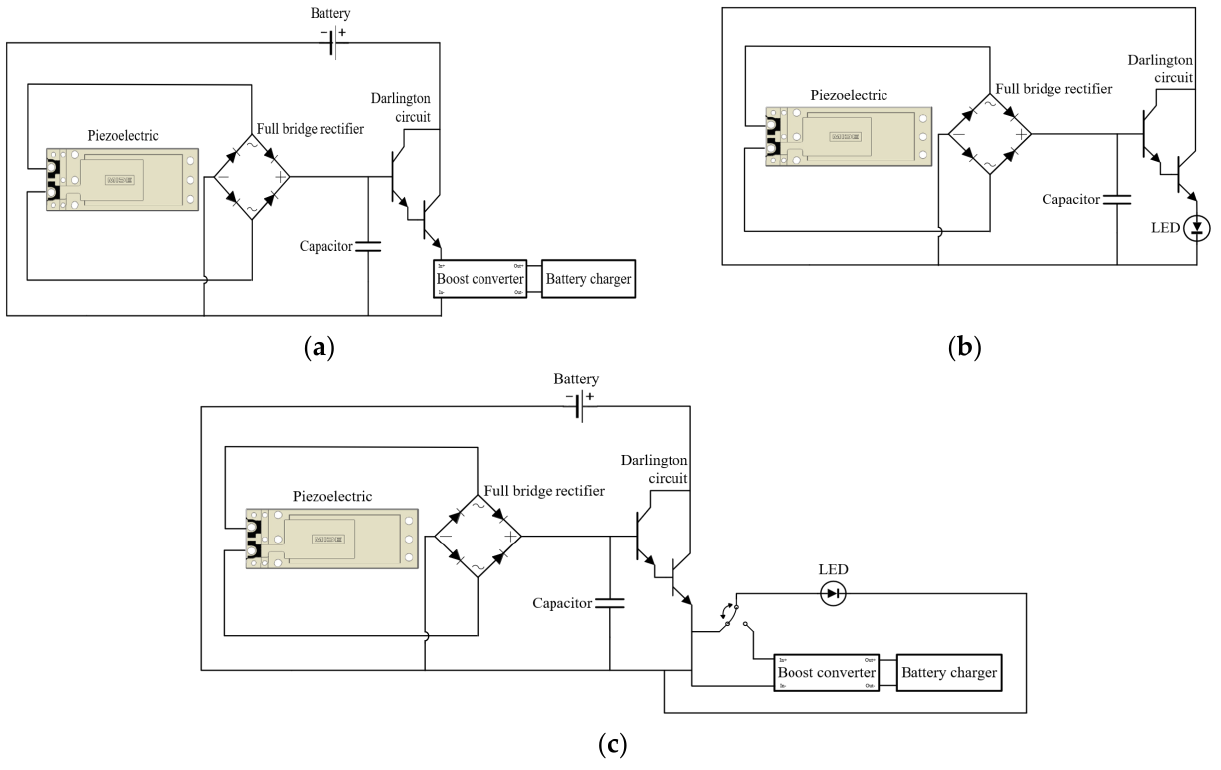
Figure 5. Proposed system for piezoelectric energy harvesting: ( a ) schematic of system for daytime operation; ( b ) schematic of system for nighttime operation; ( c ) schematic of entire system.